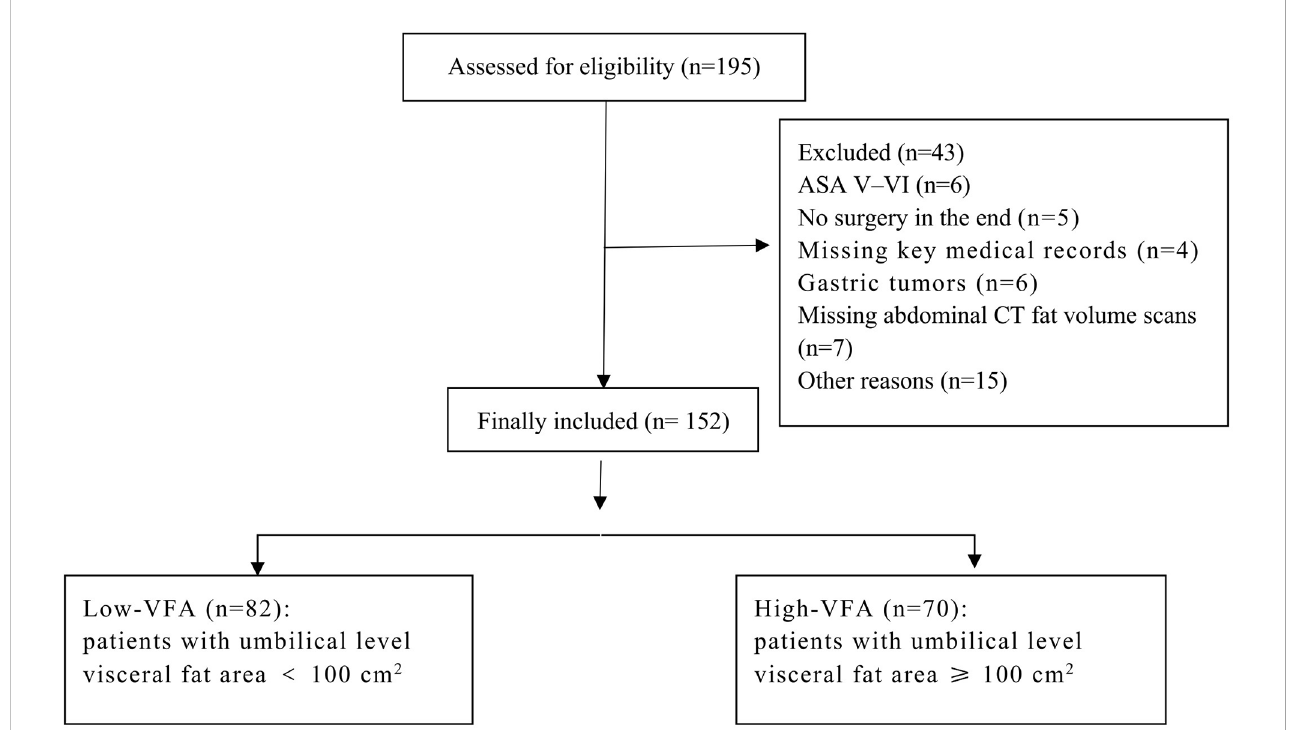
FIGURE 1 Flowchart of the patient selection process. ASA, American Society of